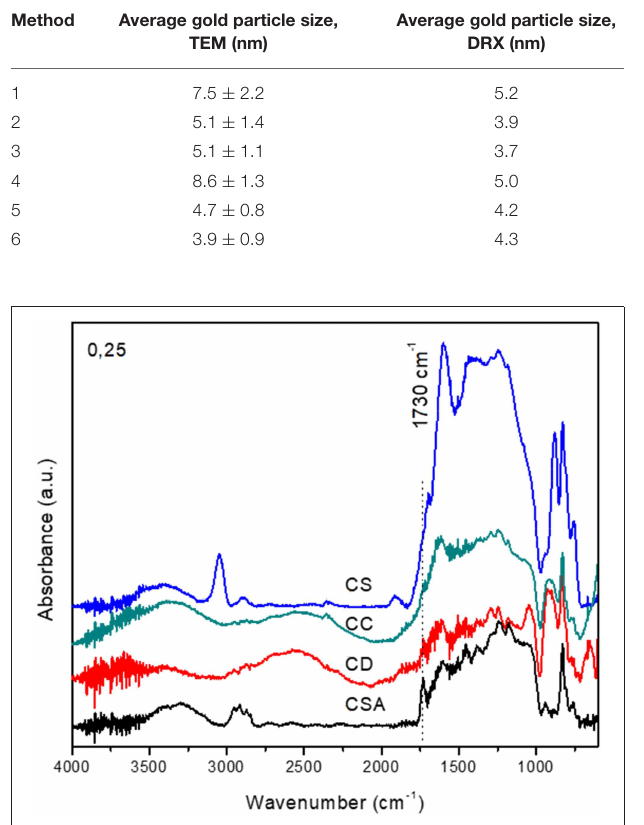
FIGURE 8 | DRIFTS spectra of the employed charcoals.